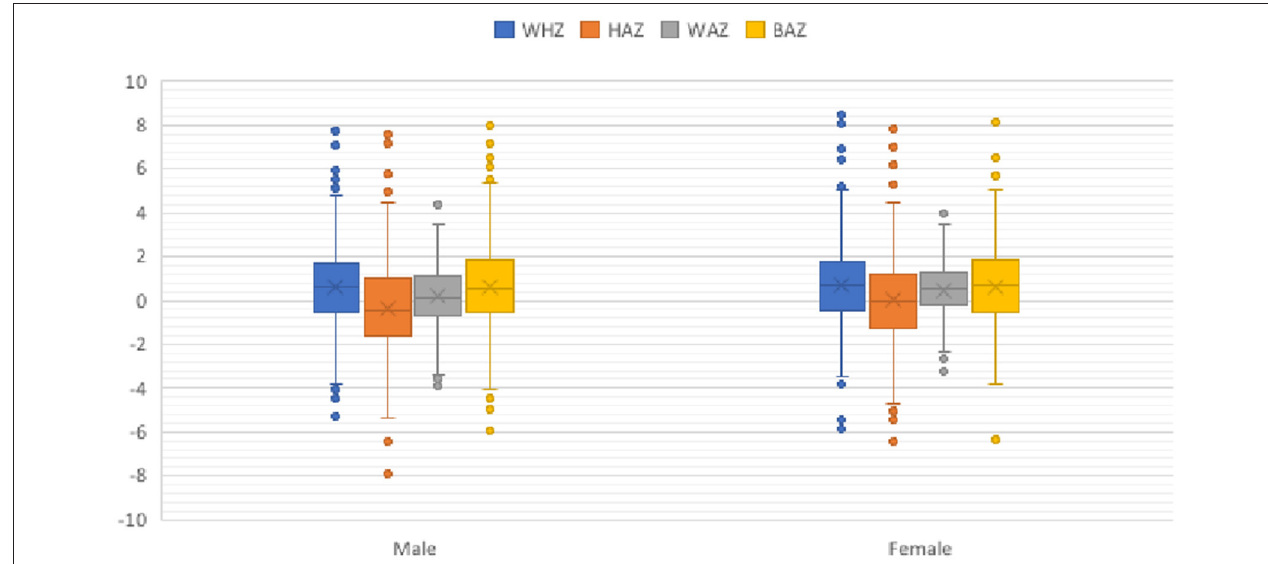
FIGURE 2 | Child anthropometrics by sex. BAZ, body mass index for age z-score ( < -2 SD, low BMI); HAZ, height-for-age z-score ( < -2 SD, stunted); WAZ, weight-for-age z -score ( < -2 SD, underweight); WHZ, weight-for-height z-score ( < -2 SD,